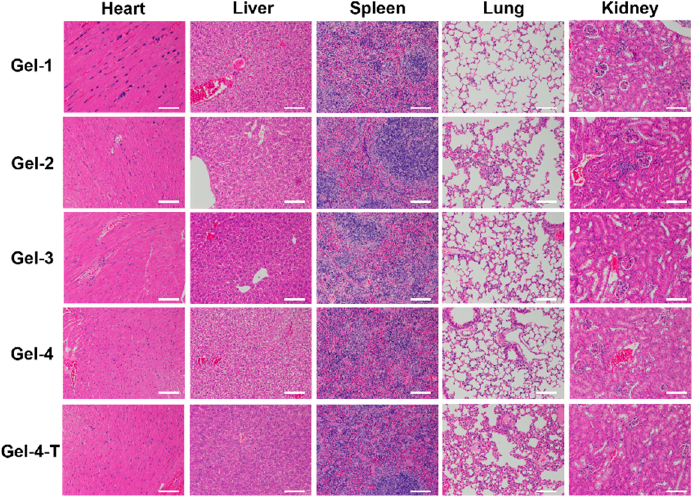
Figure 9. In vivo toxicity assessment of hydrogels. Hematoxylin–eosin (H&E) stained tissue slices (liver, spleen, kidney, heart and lung) of mice injected with hydrogels after 24 h (the white scale bar is 200 µm).